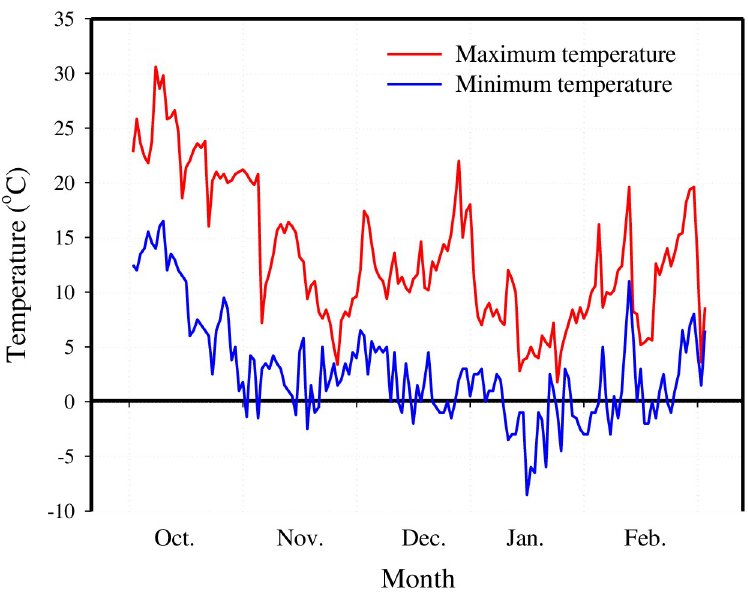
Fig 1. Minimum and maximum daily air temperatures at the experimental site from October 2019 to February 2020. Relative humidity of 40–50% under the natural photoperiod [3].